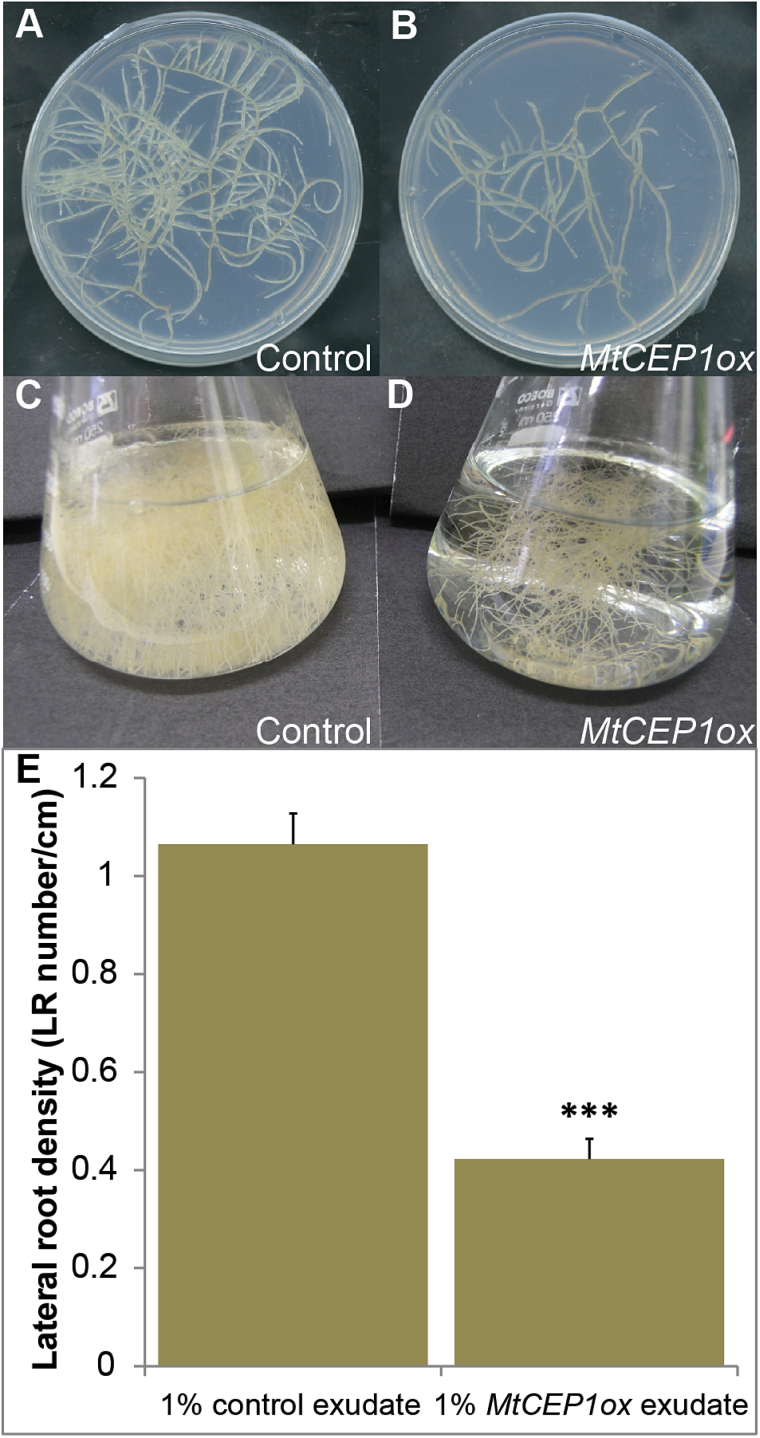

Strategy for enriching and bioassaying MtCEP1 peptides using root cultures. (A–D) Axenic root cultures containing either the vector (A, C) or MtCEP1ox (B, D). Root cultures were maintained on solidified Fåhraeus medium (A, B) prior to sub-culturing in liquid Fåhraeus medium (C, D) for peptide isolation. (A) and (B) show one week’s growth after adding an equally-sized root segment to the agar plates and (C) and (D) show two week’s growth in the liquid medium after equally sized root segments were initially sub-cultured. (E) The concentrated exudates from vector control and MtCEP1ox root cultures were incorporated into Fåhraeus medium to a final concentration of 1% of that present in the harvested flasks and bioassayed for inhibition of emerged lateral root number on wild type A17 seedlings (measured as LR number/cm) n=12.